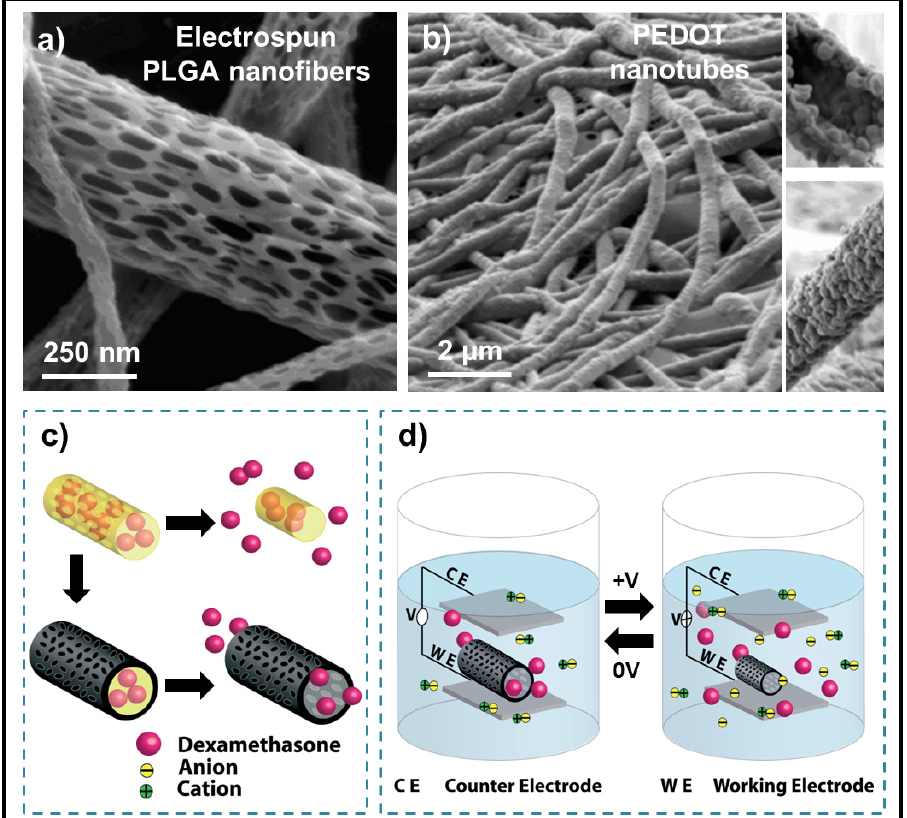
Figure 25. Scanning electron micrographs of ( a ) PLGA nanosfibers and ( b ) poly(3,4-ethylenedioxythiophene) (PEDOT) nanotubes after removing the PLGA